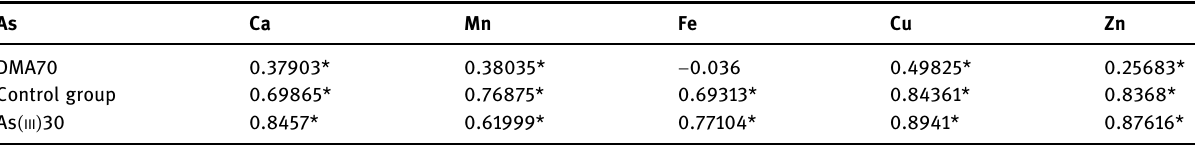
Table 3: Pearson coe ffi cient ( R ) of correlation between As and other elements in honeysuckle leaf samples As Ca Mn Fe Cu